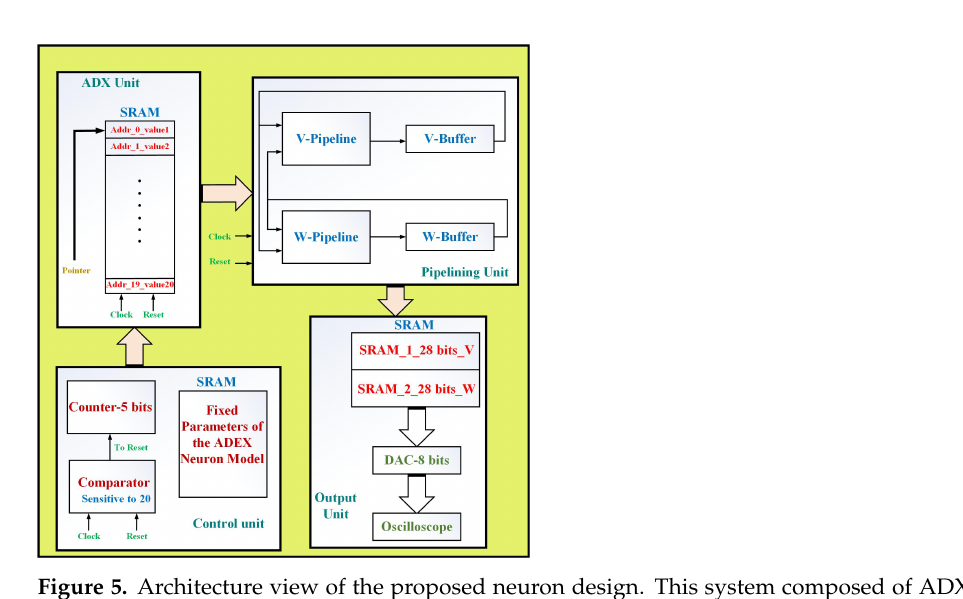
Figure 5. Architecture view of the proposed neuron design. This system composed of ADX unit, pipelining unit, control unit and output unit.